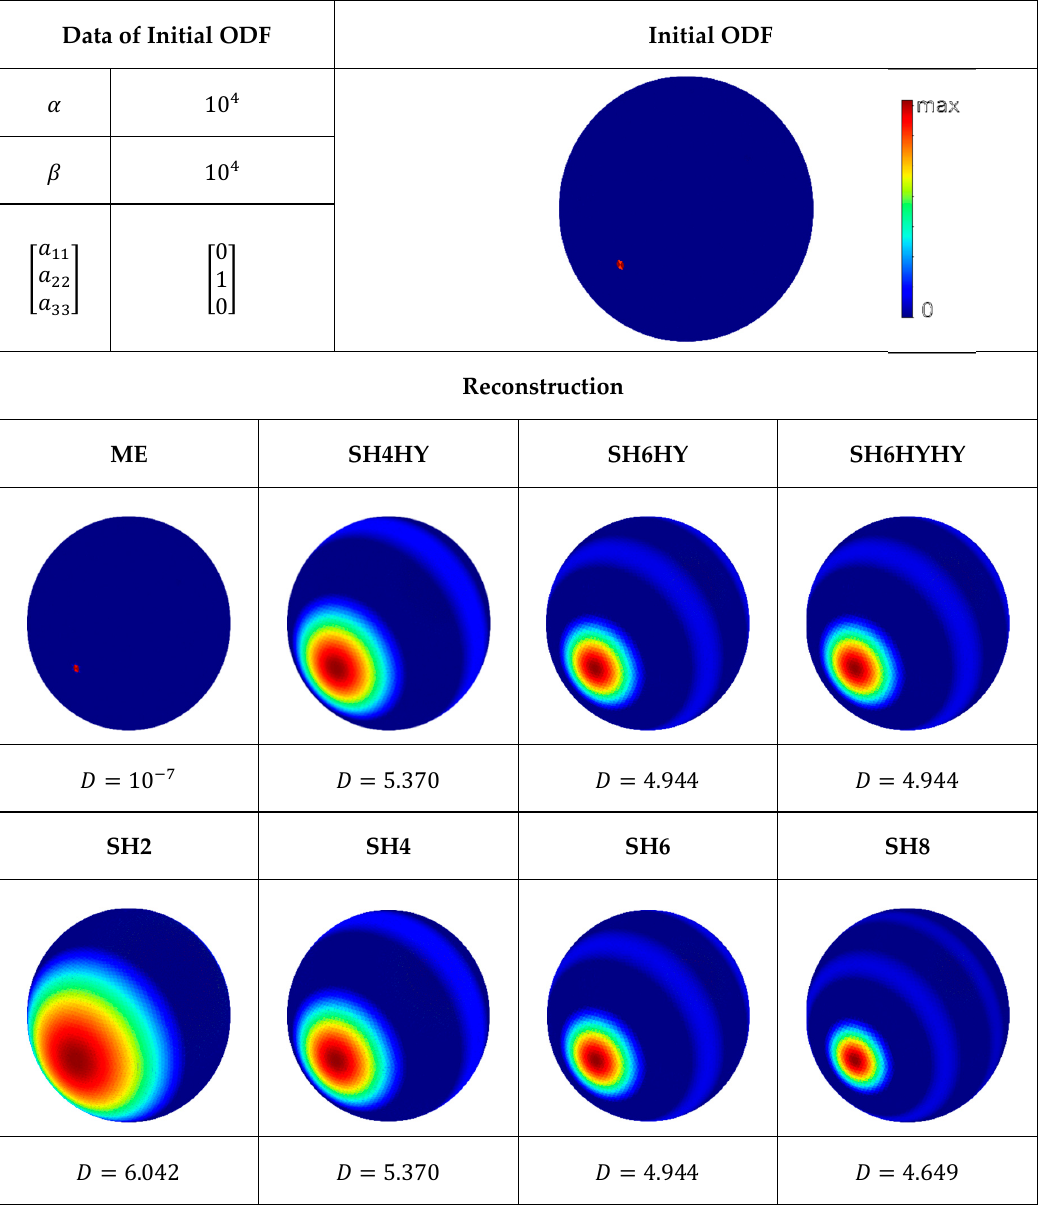
Figure 4. Top: Initial ODF and data of first test case. Bottom: Reconstruction of test case with the different reconstruction methods.